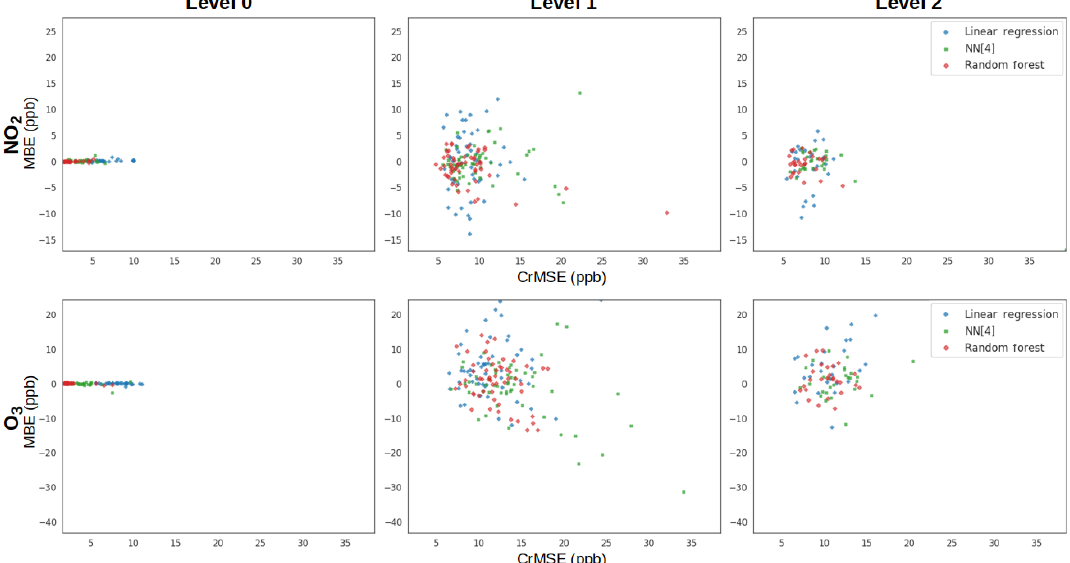
Figure 7. Target plots for Level 0 through Level 2 for both NO 2 and O 3 . In each panel, the centered error is plotted on the x axis, while the bias error (MBE) is plotted on the y axis. The differing colors then illustrate the performance of each calibration model at each level and for these metrics. Each point in the plot corresponds to a different individual benchmark (i.e., a unique round, location, and board).